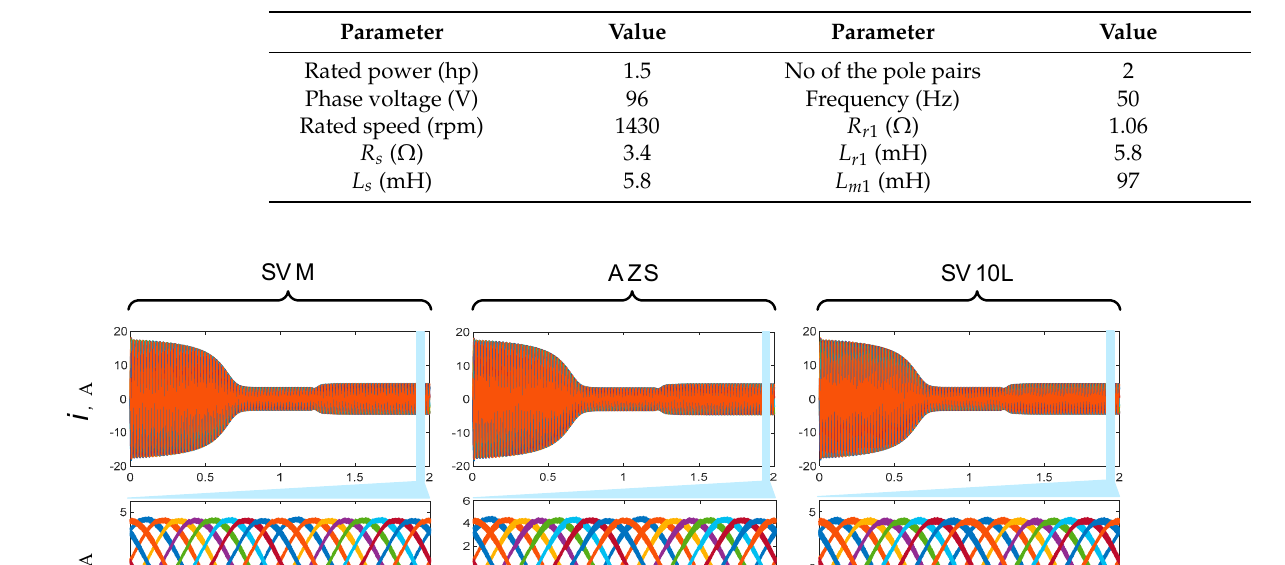
( c ) SV-10L Figure 8. FFT analysis for the output phase voltage of the conventional SVM and proposed CMVR schemes.